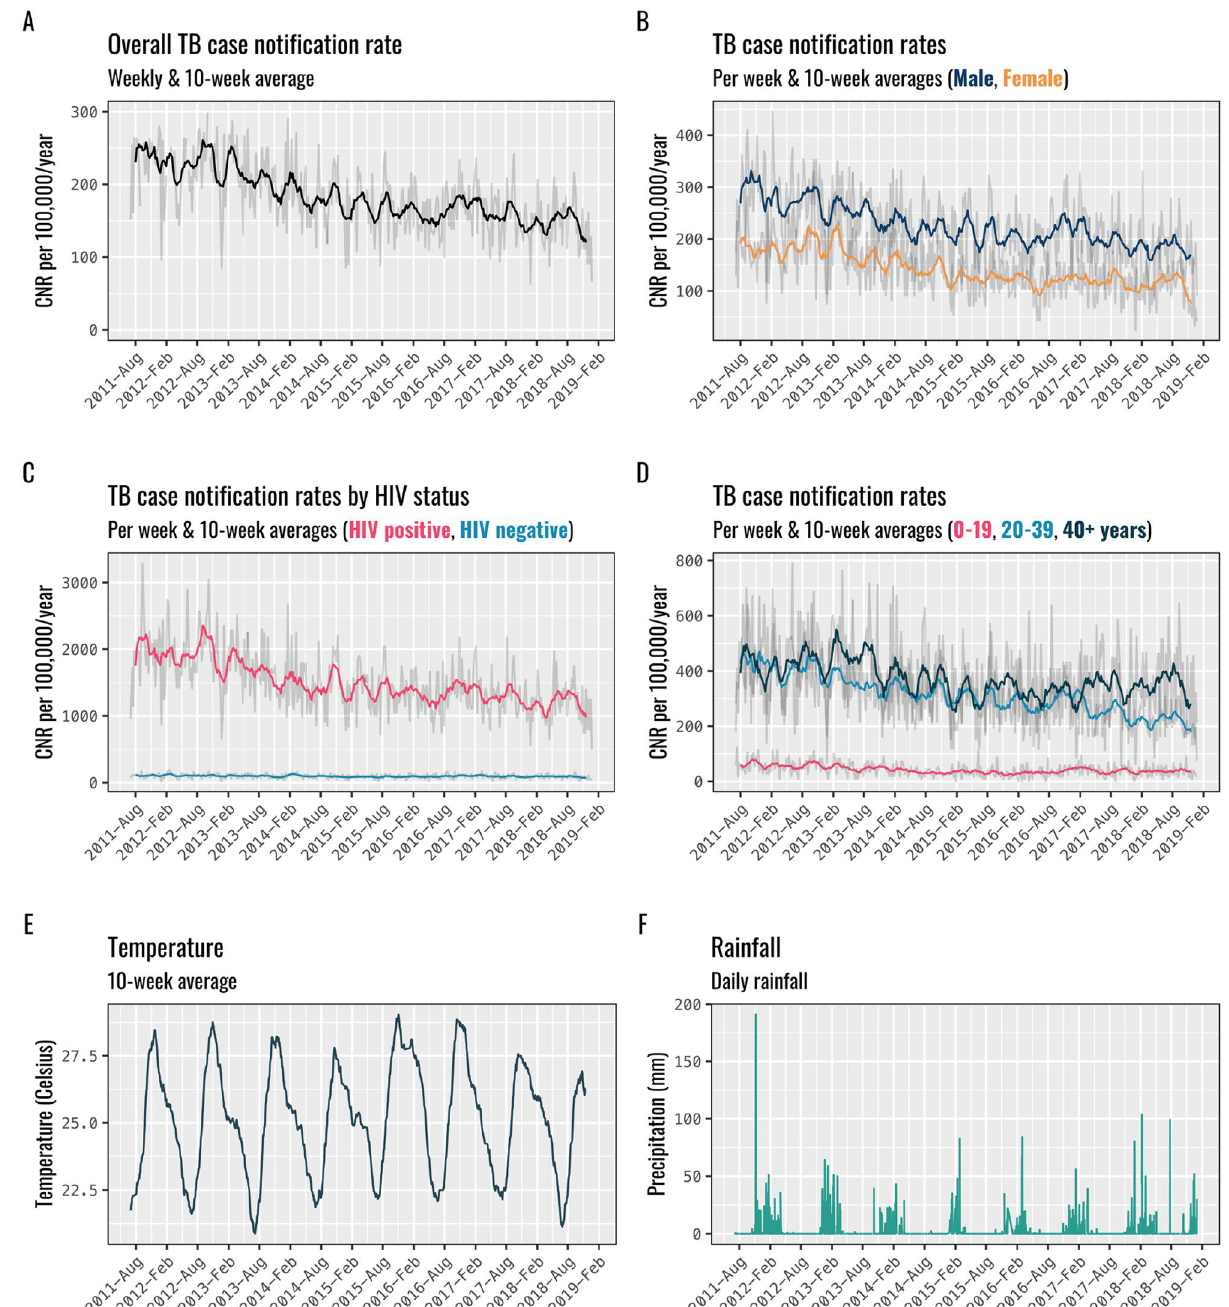
Figure 1. Blantyre tuberculosis case notification rates, average weekly rainfall and temperature (April 2011– December